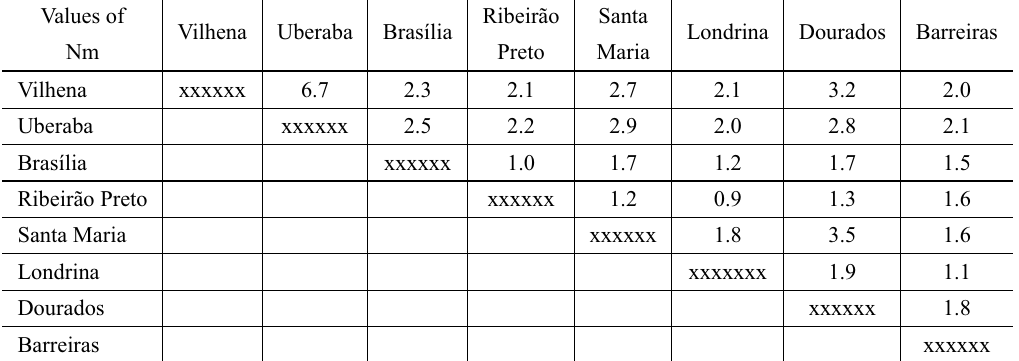
Paired comparisons among populations of Chlosyne lacinia saundersii through the Nei coefficient for the gene flow ( Nm )